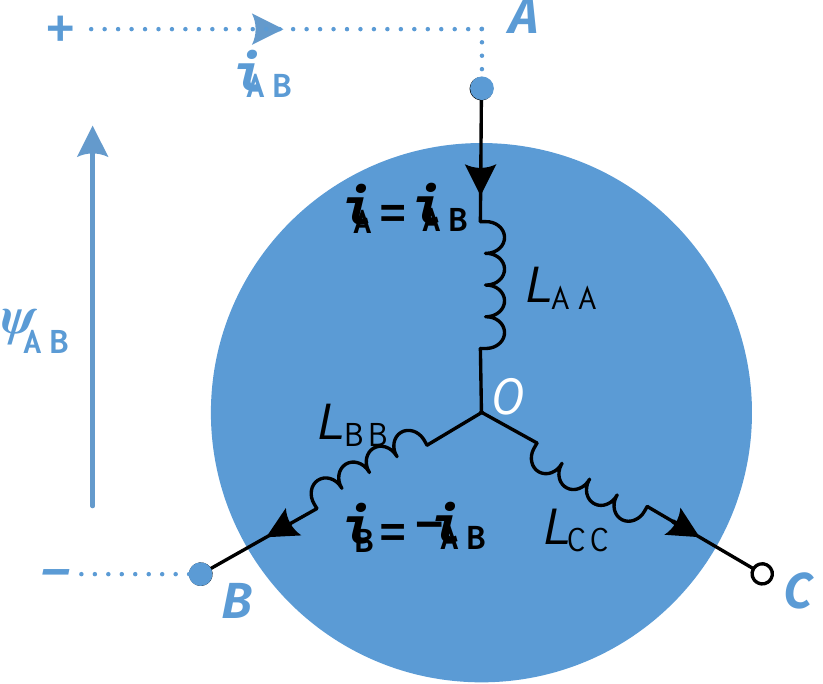
Figure 2. Equivalent circuit when a high frequency AC voltage is applied to phase A and B of a healthy motor.